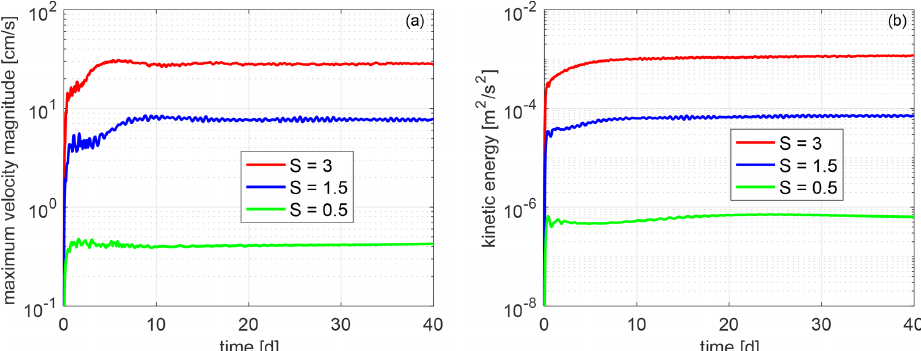
Figure 4. Maximum velocity magnitudes (a) and kinetic energies (b) for the seamount test case for three Burger numbers. The maximum topographic stiffness ratio r max = 0 .